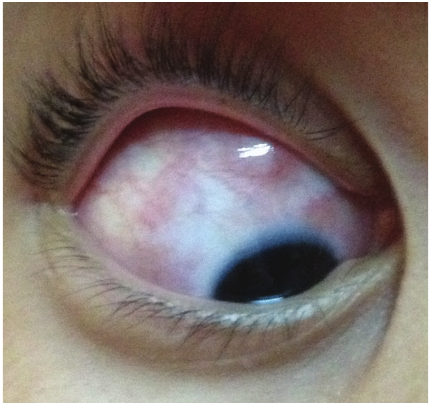
Figure 1: Left eye showing nodular scleral lesions in front of the rectus muscles at time of presentation. Figure 2: Right eye showing less prominent superior scleral lesions